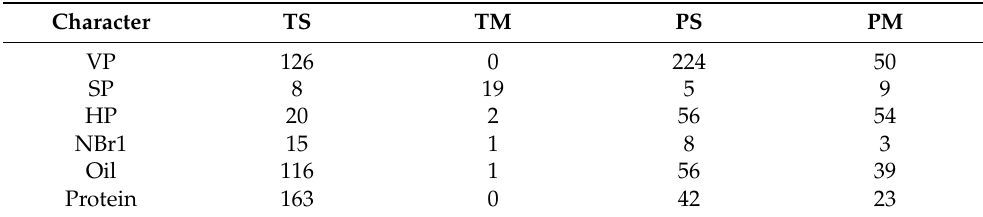
Table 5. Number of significant linear regression coefficients between plant characters and meteoro- logical parameters.